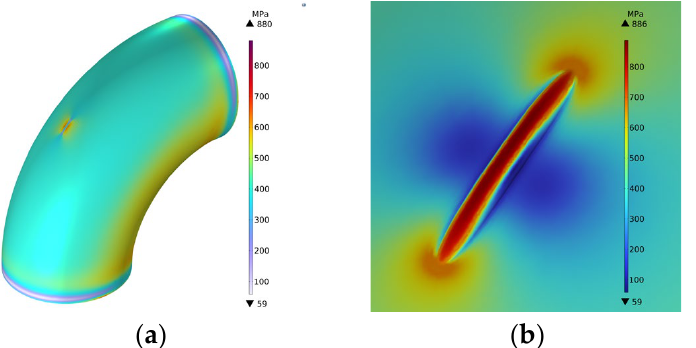
Figure 13. Stress diagram. ( a ) Overall stress diagram; ( b ) Schematic diagram of stress at the defect.